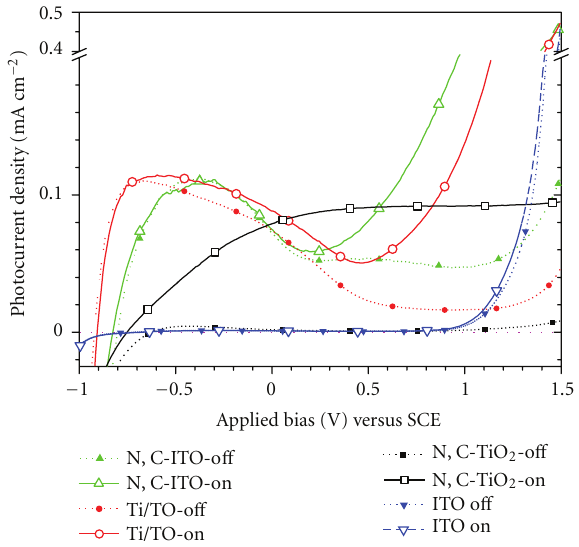
Figure 6: Photocurrent response of the Ti/TO and N,C-TiO 2 electrodes along with N,C-ITO and ITO substrates in Na 2 CO 3 solution.